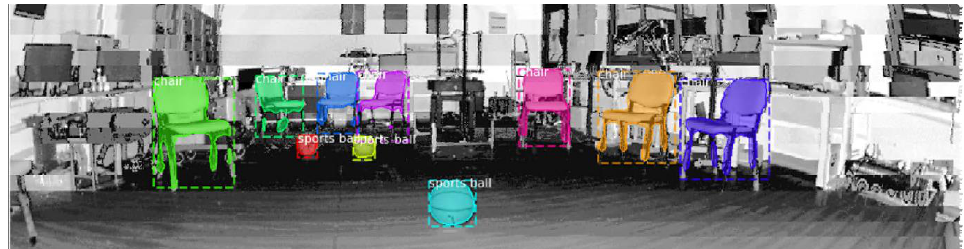
Figure 30. The 2D segmentation results from Mask RCNN of the indoor scene.